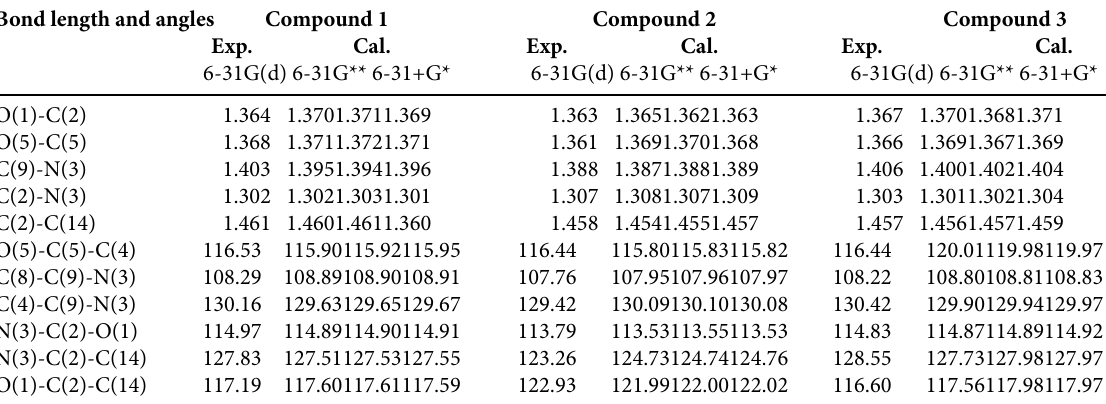
Table 3. Bond lengths [A] and angles [deg] of compounds 1, 2 and 3